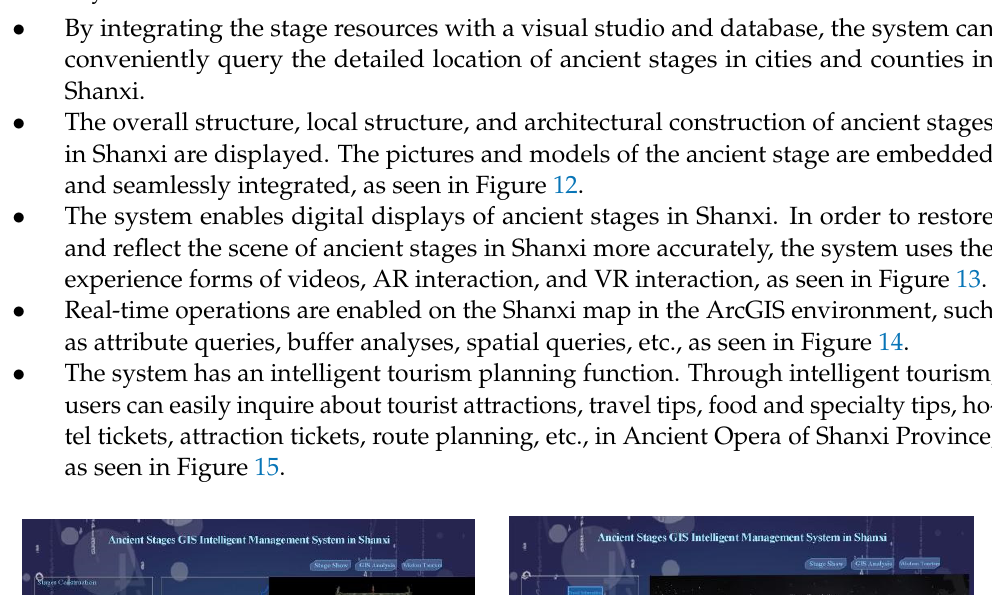
( a ) ( b ) Figure 13. Digital display. ( a ) Digital short film. ( b ) AR interaction. ( a ) ( b ) Figure 14. Spatial analysis in GIS. ( a ) Buffer analysis. ( b ) Attribute query. ( a ) ( b ) Figure 15. Intelligent tourism. ( a ) Introduction of sites. ( b ) Optimal route planning. 4. Conclusions The conservation and use of architectural heritage sites, especially scattered ancient stage heritage sites, are significant and valuable. This work requires interdisciplinary col- laboration. This research, combining technological and humanistic knowledge, proposed